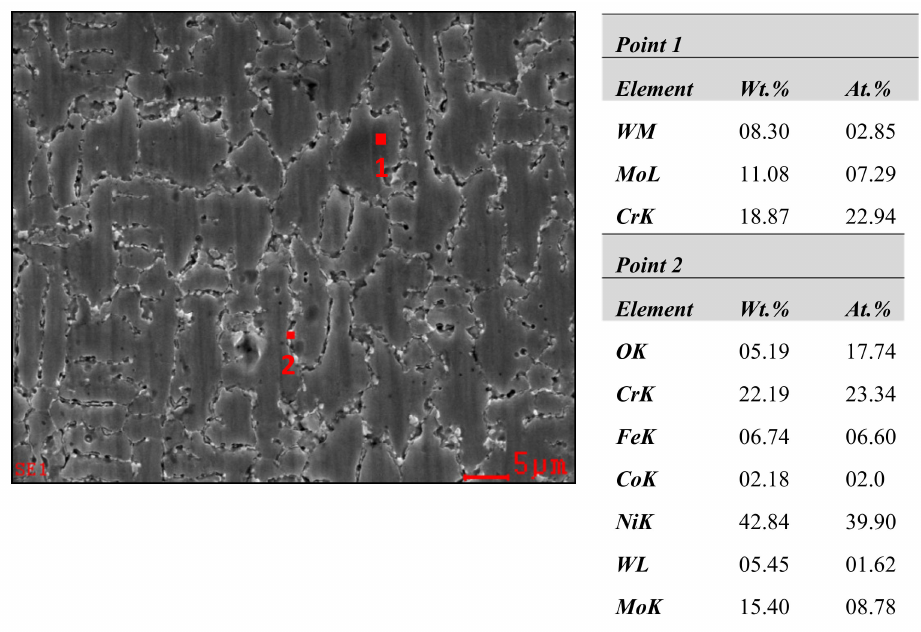
Figure 8. Elemental content analysis of the C22 coating corroded at 60 ◦ C by